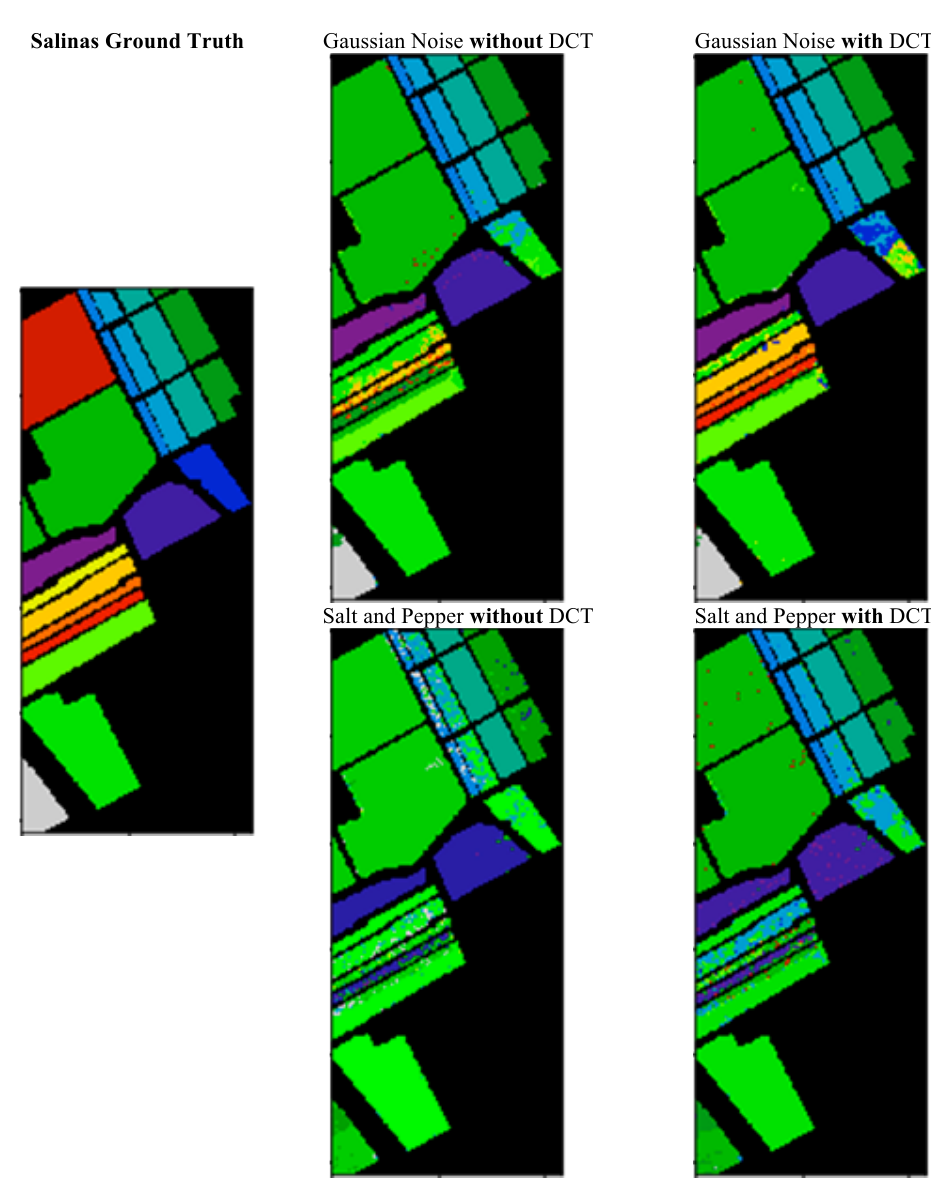
Figure 7: Salinas Dataset: Classification maps for indicative CNN-based